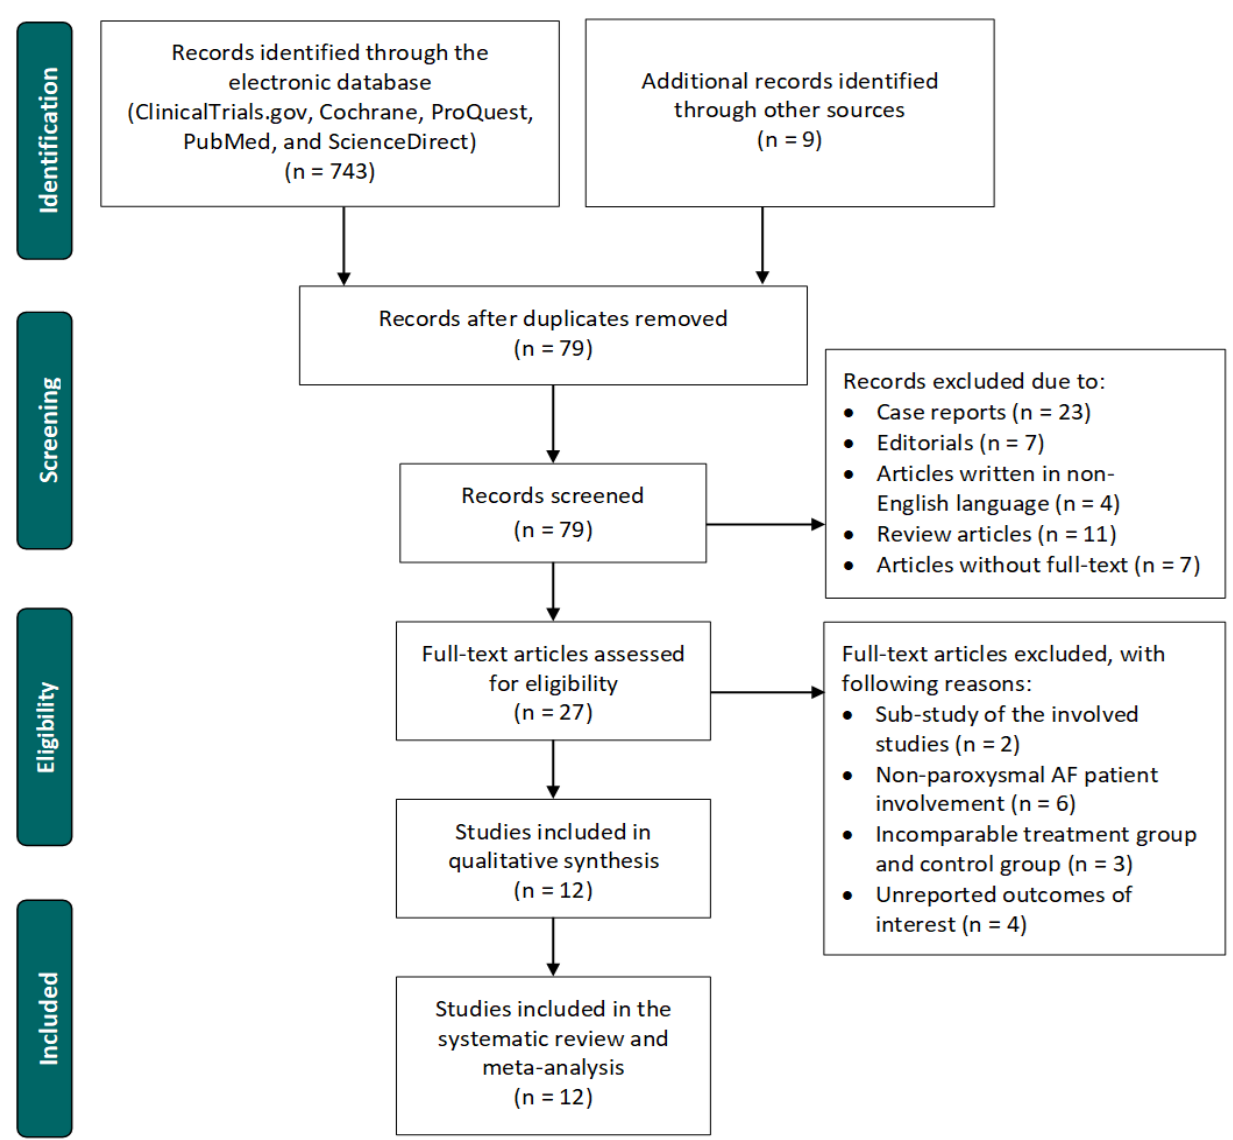
Figure 1. Flowchart of the study selection process. AF = atrial fibrillation.